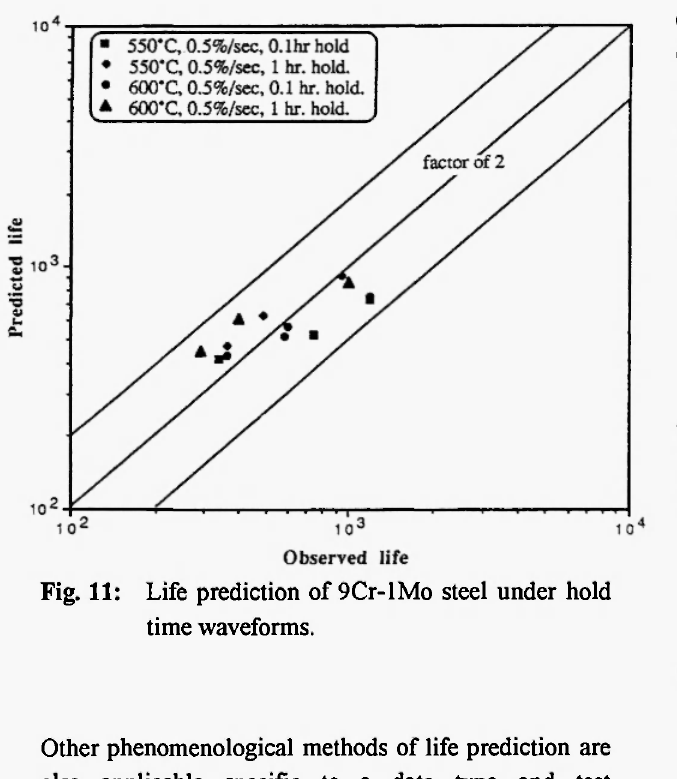
Fig. 11: Life prediction of 9Cr-lMo steel under hold time